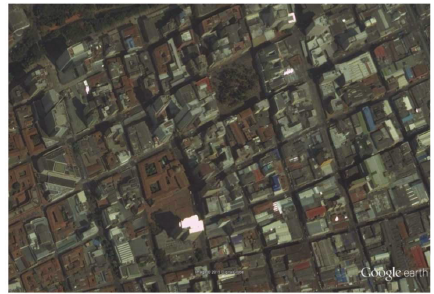
Figure 9: Downtown Ottawa City, Canada, from Google Earth.